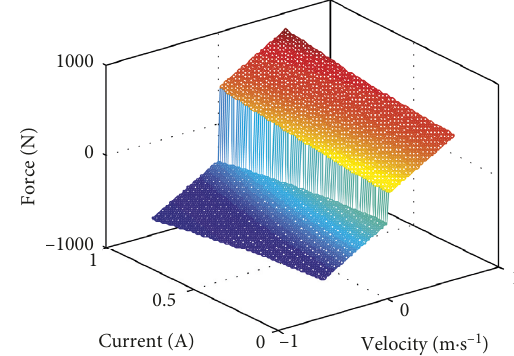
Figure 2: Hysteresis model of the MR